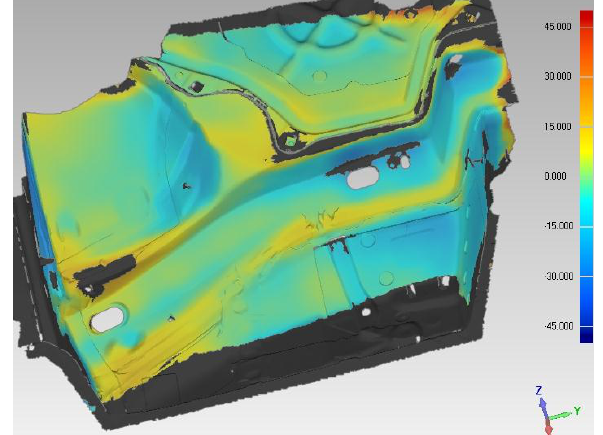
Figure 10. Best-fit analysis to reference